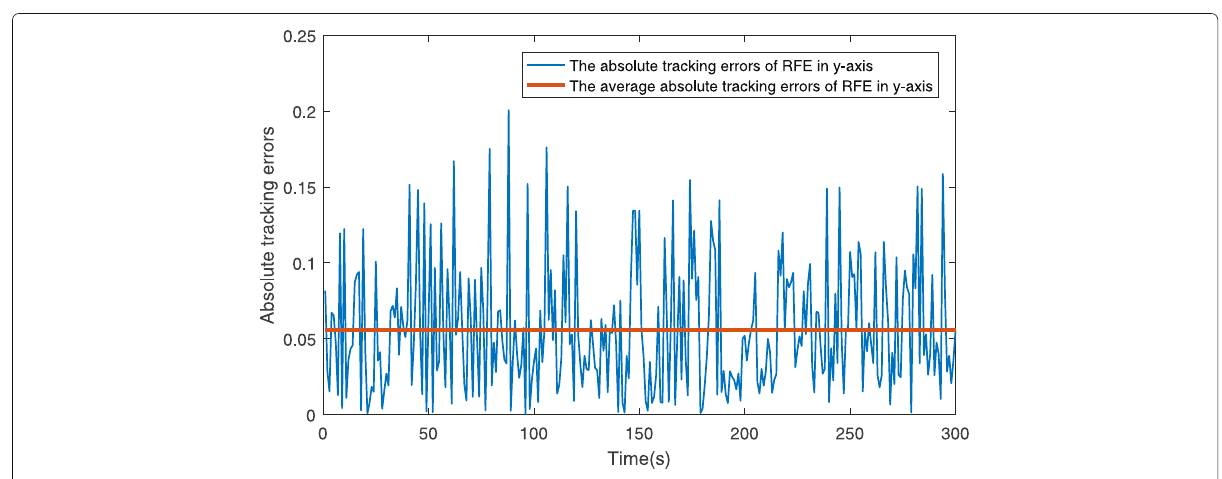
Fig. 25 The absolute tracking errors of RFE in y-axis with a i =